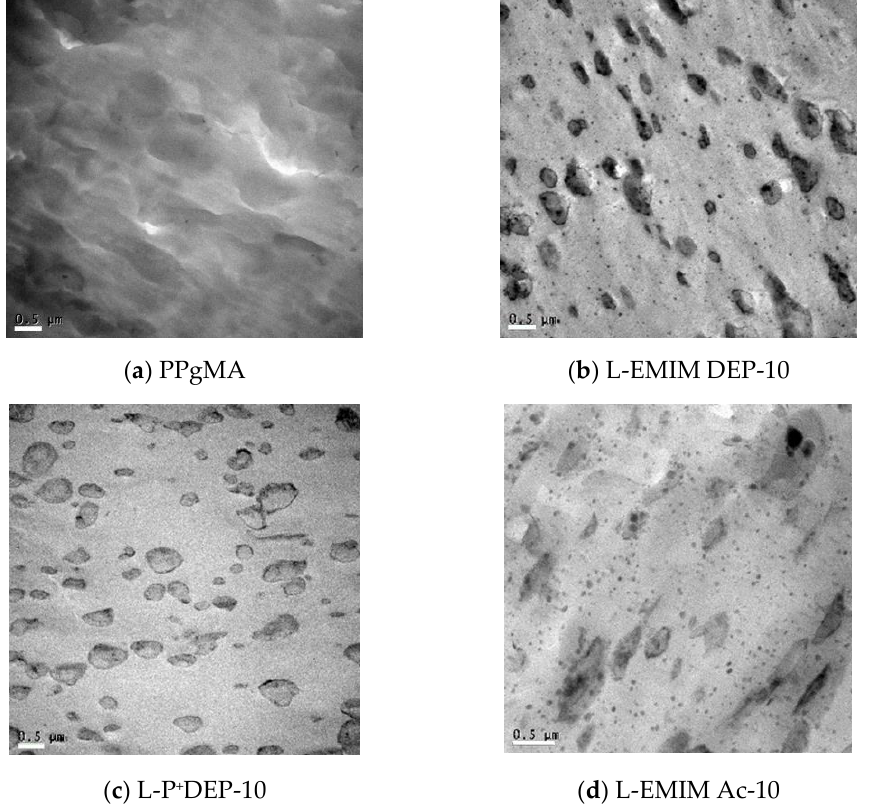
Figure 2. Transmission Electron Microscopy (TEM) images of PPgMA and related LIonomers containing 10 wt% of IL (scale bar: 0.5 µ m), ( a ) PPgMA; ( b ) L-EMIM DEP-10; ( c ) L-P + DEP-10; ( d ) L-EMIM Ac-10.